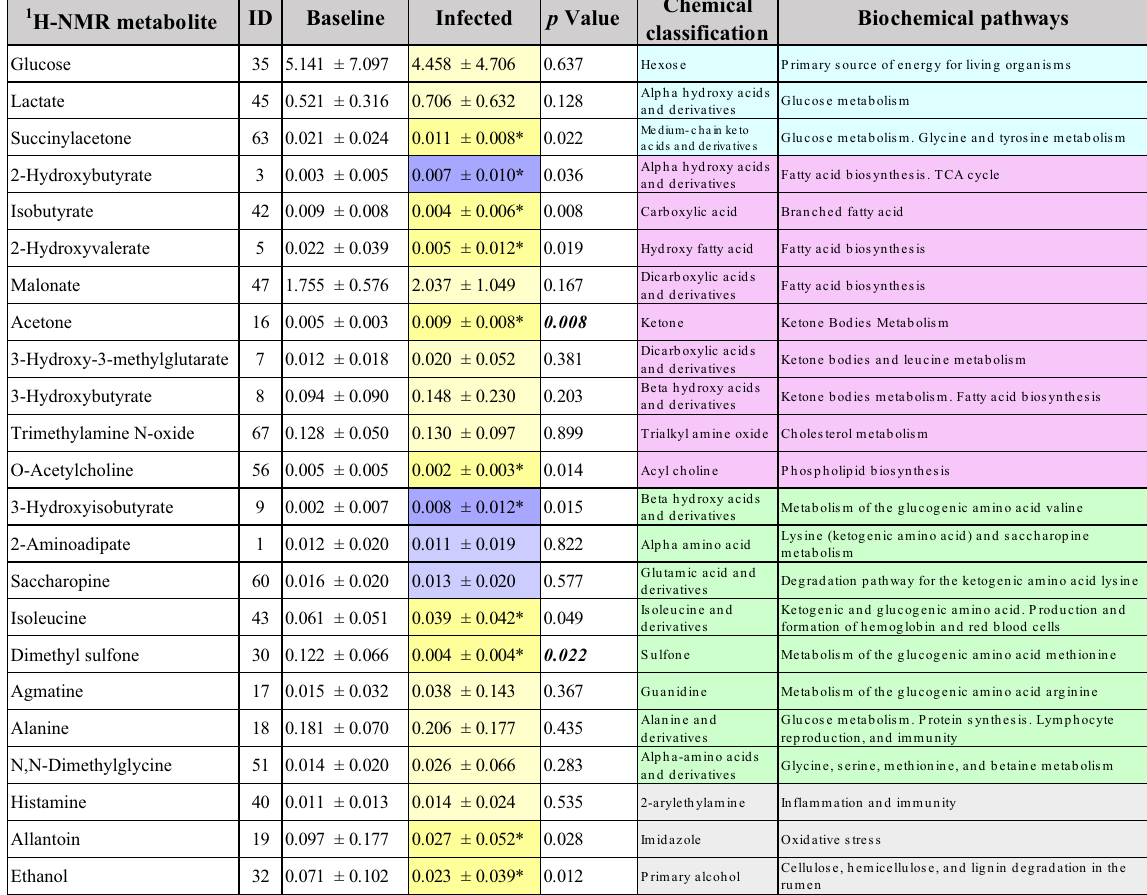
Table 3. Baseline vs. Infected (V + B) changes in metabolite concentration. Values are presented as mean ± SD. Data were analyzed using Student’s t -test with an α < 0.05 delineating significant treatment effects (*), increase (dark purple), decrease (dark yellow). Values positively (light purple) or negatively correlated (light yellow) in the PCA during infection compared with the Baseline. Biochemical pathways: Grey = other; light blue = glycolysis/gluconeogenesis pathways, magenta = triglycerides pathways, light green = protein pathways. Italic = parameter changed in both the ANOVA and the